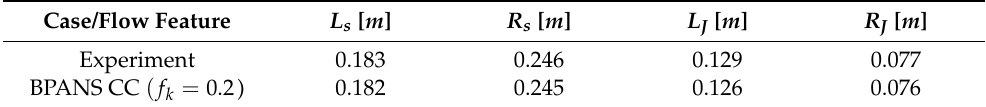
Table 1. SRP geometrical flow features compared to experimental data